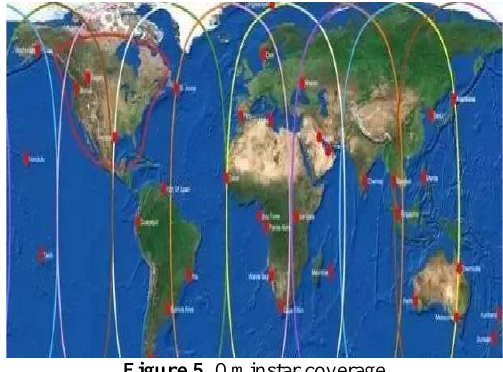
Figure 5. Ominstar